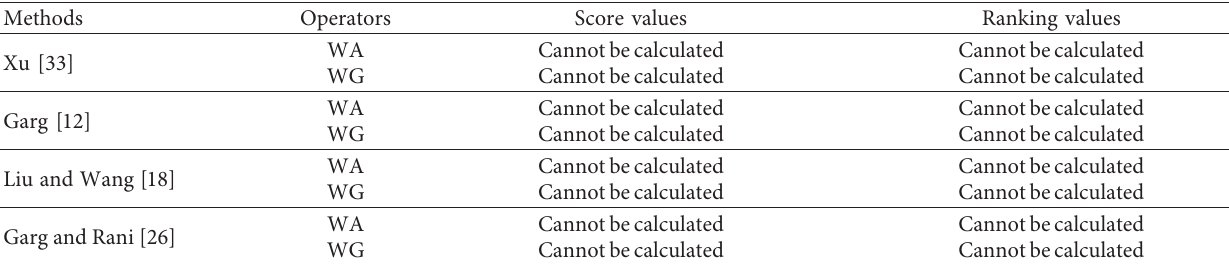
Table 8: Comparative analysis for the information of Table 3 corresponding to Example